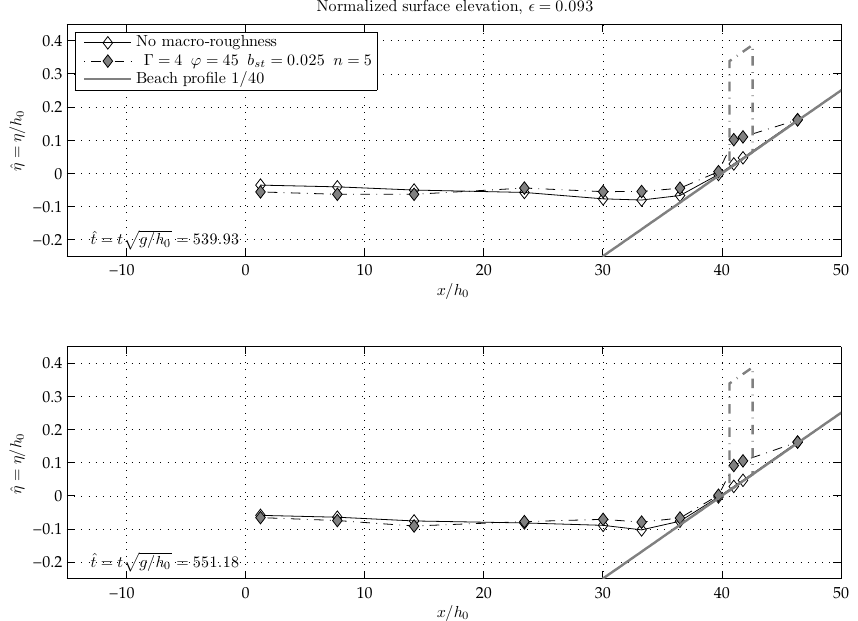
Fig. 16. Comparison of the normalized surface elevation for a sinusoidal wave with (cid:15) = 0 . 093 at ˆ t = 539 . 93 and ˆ t = 551 . 18 with and without the presence of macro-roughness elements. The macro-roughness element configuration is specified by 0 = 4, ϕ = 45 ◦ , b st = 0 . 025 and n = 5. Surface elevation and spatial coordinates are normalized by the invariant water depth ( h 0 ). The dash-dotted line depicts the macro- roughness element